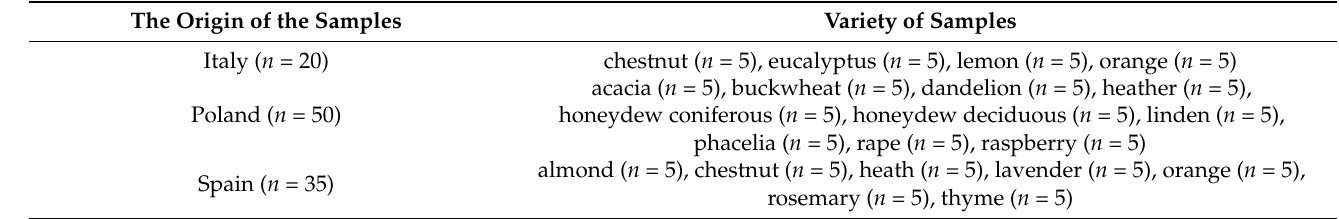
Table 1. Characteristics of the analyzed honeys—breakdown in accordance with the manufacturers’